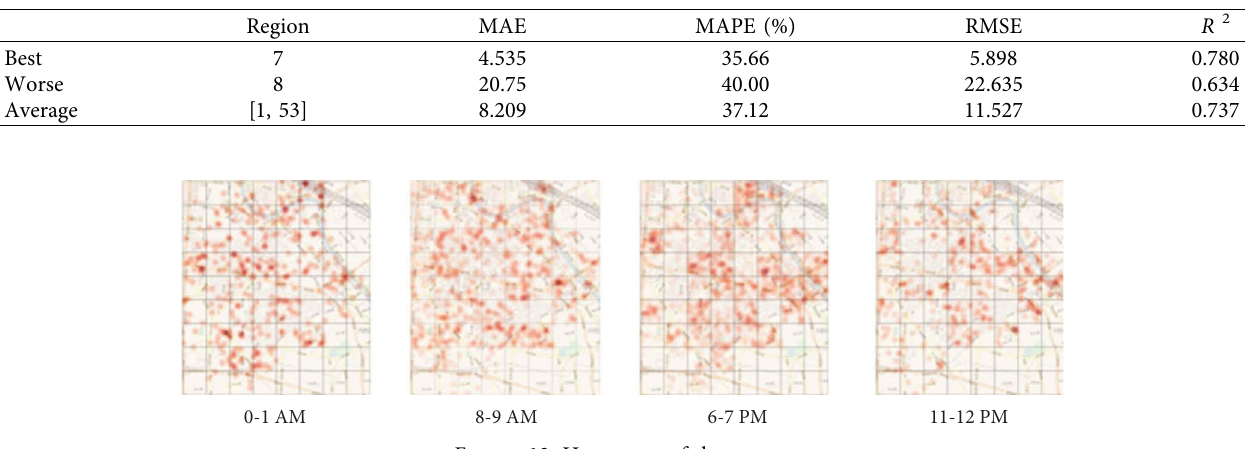
Figure 11: MAE of each region. Table 2: Predictions for region 7 and region 8.